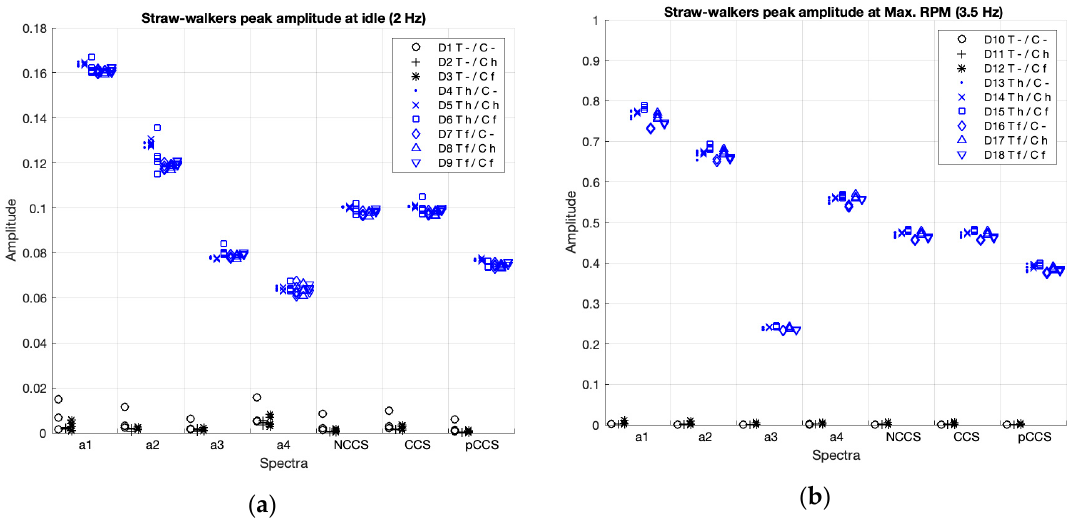
Figure 9. Peak amplitudes of the straw walkers in the individual spectra (a1–4) and the non-coherent (nCCS), coherent (CCS), and poly-coherent (pCCS) composite spectra, at idle ( a ), and at maximum RPM ( b ). The cases where the components are activated are shown in blue and the deactivated components are shown in black. Table 5. Sample description and statistical comparison of the peak amplitudes of the straw walkers in the individual spectra (a1–4) and the non-coherent (nCCS), coherent (CCS), and poly-coherent (pCCS) composite spectra, under two working conditions (deactivated, activated) and (at idle and at max. RPM) speeds.